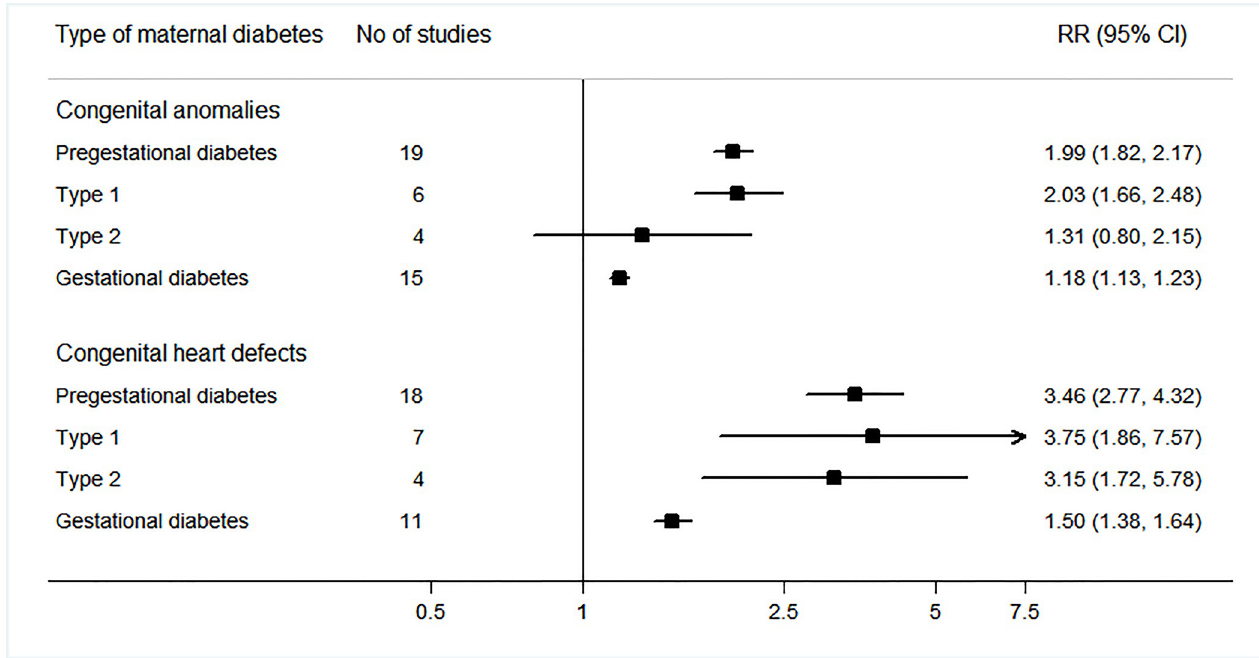
Fig 6. Risks of overall congenital anomalies and congenital heart defects in offspring according to different types of maternal diabetes. Relative risks (RRs) and 95% confidence intervals (CIs) are presented to show the risk of overall congenital anomalies and congenital heart defects in offspring born to women with different types of maternal diabetes compared with the risk among offspring born to women without diabetes. P meta-regression values were < 0.001 for the comparison within congenital anomalies and congenital heart defects between gestational diabetes and pre-gestational diabetes.